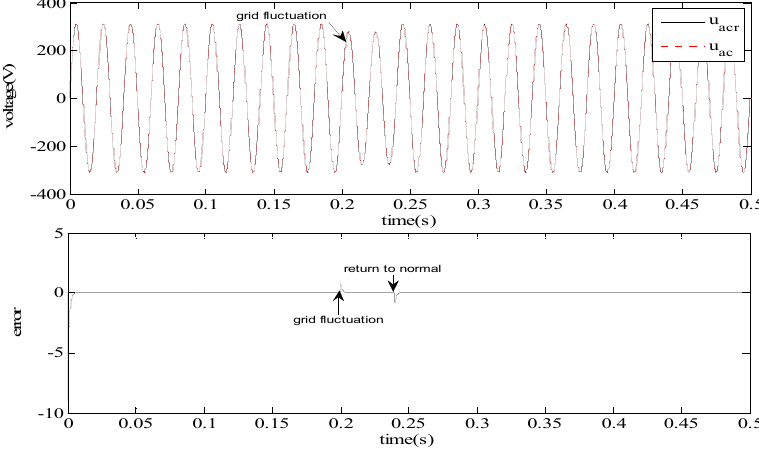
Figure 13. Performance when grid voltage fluctuates.